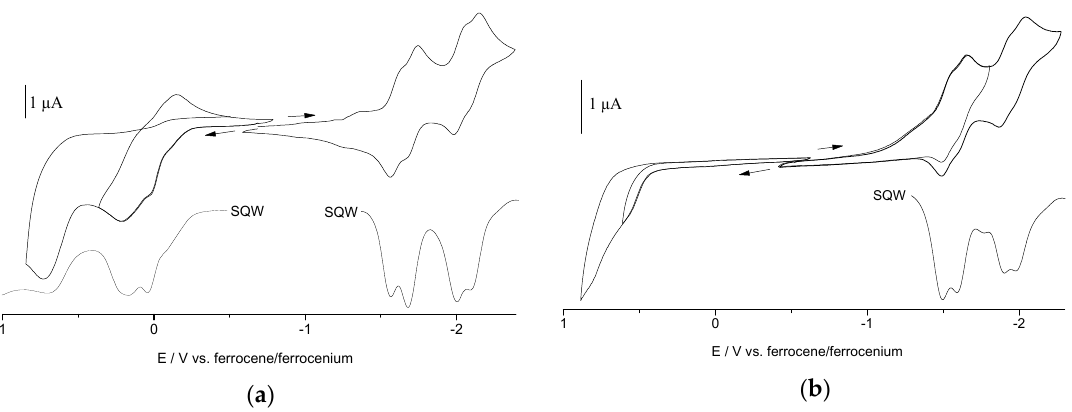
Figure 5. Cyclic voltammograms and square-wave voltammograms (SQWs) of the complexes [Ni 4 (L i Pr ) 4 ] ( a ) and [Zn 4 (L i Pr ) 4 ] ( b ) in n Bu 4 NPF 6 /THF solution at 298 K and 20 mV/s scan rate; potentials/V vs. ferrocene/ferrocenium. Table 1. Selected electrochemical data for H 2 L R and tetrameric complexes [M 4 (L R ) 4 ] 1 .